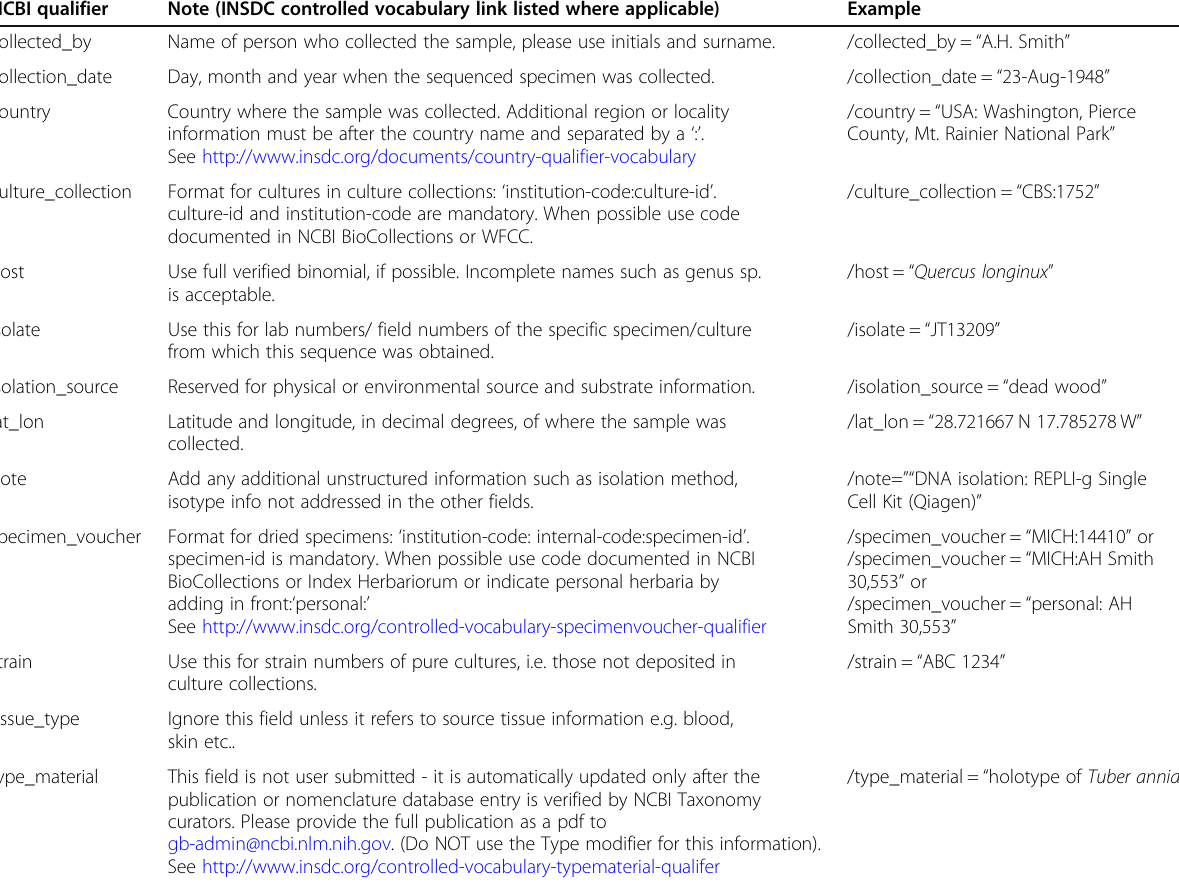
Table 1 Most commonly used modifiers recommended for public biodiversity sequence